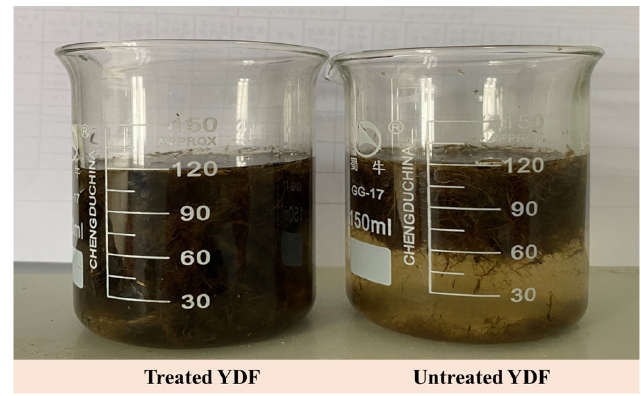
Figure 2. The dispersion of treated YDF and untreated YDF in water.